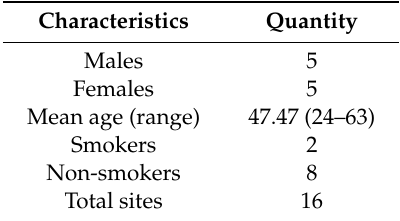
Table 1. Patient characteristics at